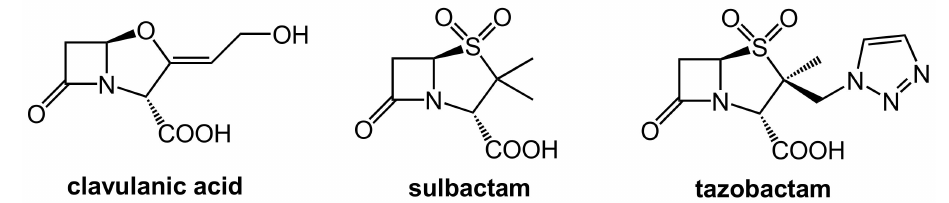
Figure 2. Structures of the β -lactam-type β -lactamase inhibitors clavulanic acid, sulbactam, and